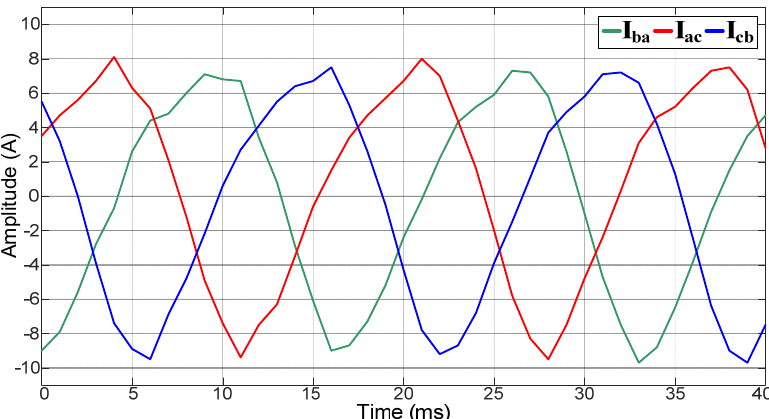
Figure 8. Line currents from an induction motor in healthy condition.